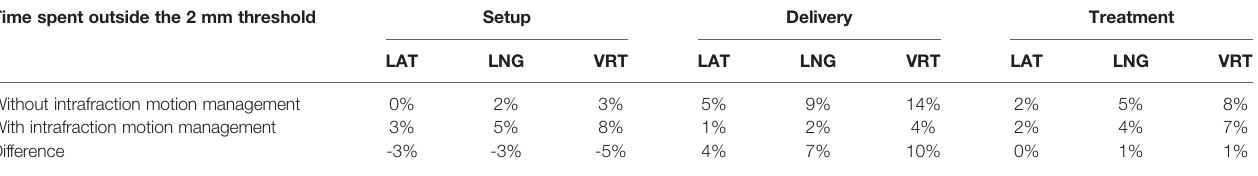
TABLE 1 | Percentage of the setup time, delivery time, and total treatment time spent by the prostate outside the 2 mm threshold by spatial direction (LAT, lateral; LNG, longitudinal; VRT, vertical) without the intrafractional organ motion management and with the real-time management. Time spent outside the 2 mm threshold